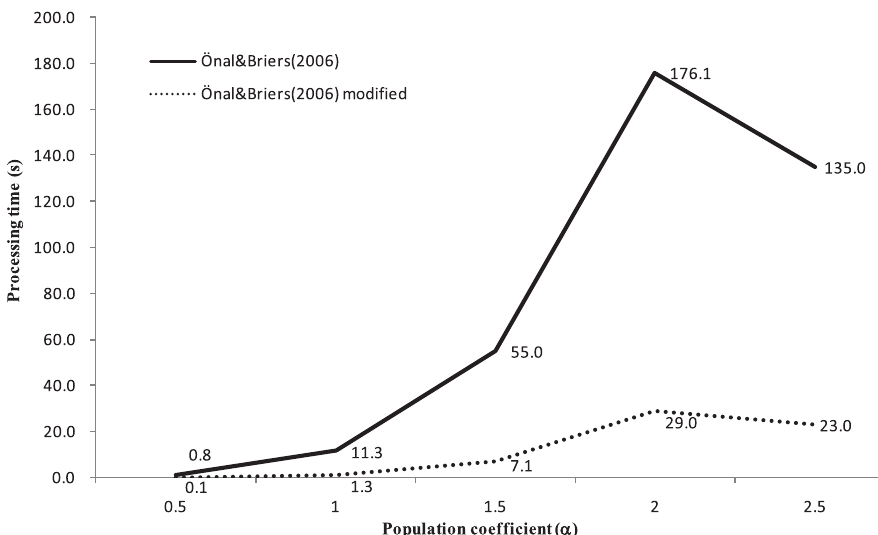
Figure 2. Significance of model structure in affecting the model’s computational efficiency (number of sites n =36. The size of population to be covered equals to α times n